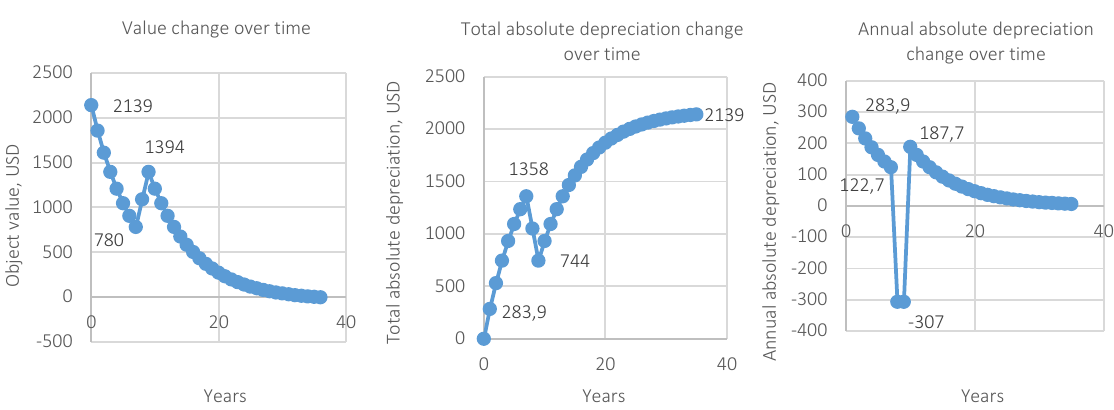
Figure 3. Graphs of the value change over time (left); total absolute accumulated depreciation (middle) and the annual (periodic) absolute depreciation (right). Proposed regressive depreciation model, based on